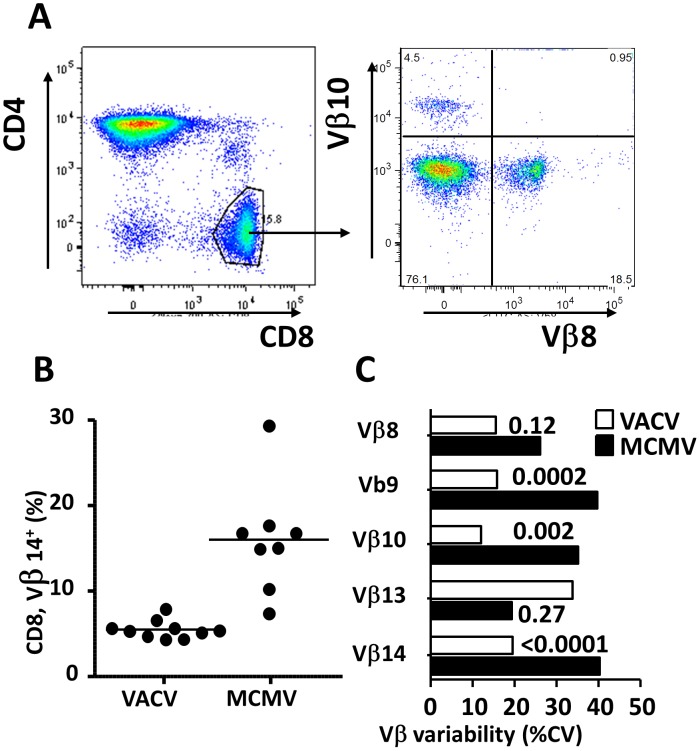
Vβ family analysis of CD8 pools upon MCMV infection.(A,B,C) BALB/cxDBA/2 F1 Mice infected at 6 months of age with MCMV or VACV-IE1 as in Fig. 1A and 1B were bled at 14 months following infection and analyzed for frequency of Vβ8, Vβ9, Vβ10, Vβ13 and Vβ14 populations. Representative gating for Vβ 8 and Vβ10 is shown (A). Frequencies of CD8 cells belonging to Vβ families were analyzed in individual mice and a representative analysis is shown for Vβ14 (B), where each mouse is displayed by a symbol, and group medians by horizontal lines. The cohort variability of Vβ population frequencies were defined in groups of MCMV or VACV infected mice (C), and are indicated as SD on the x axis. Variance F-tests were performed to identify differences in group variabilities and p values are indicated in the chart.